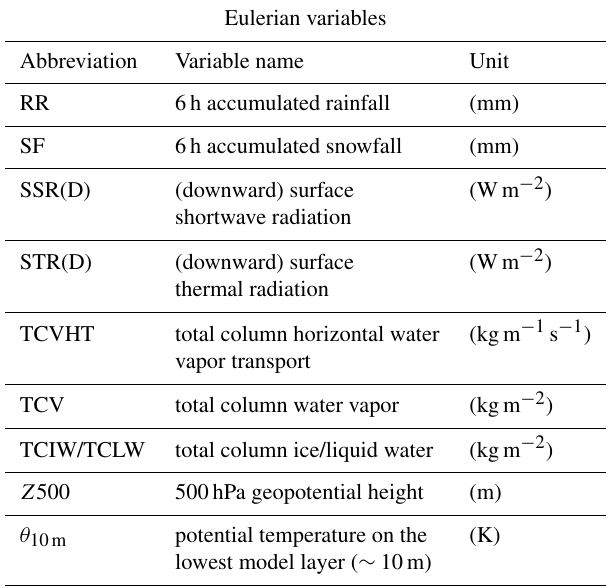
Table 1. The ERA-Interim variables used for the evaluation of the synoptic situation over the GrIS (Eulerian